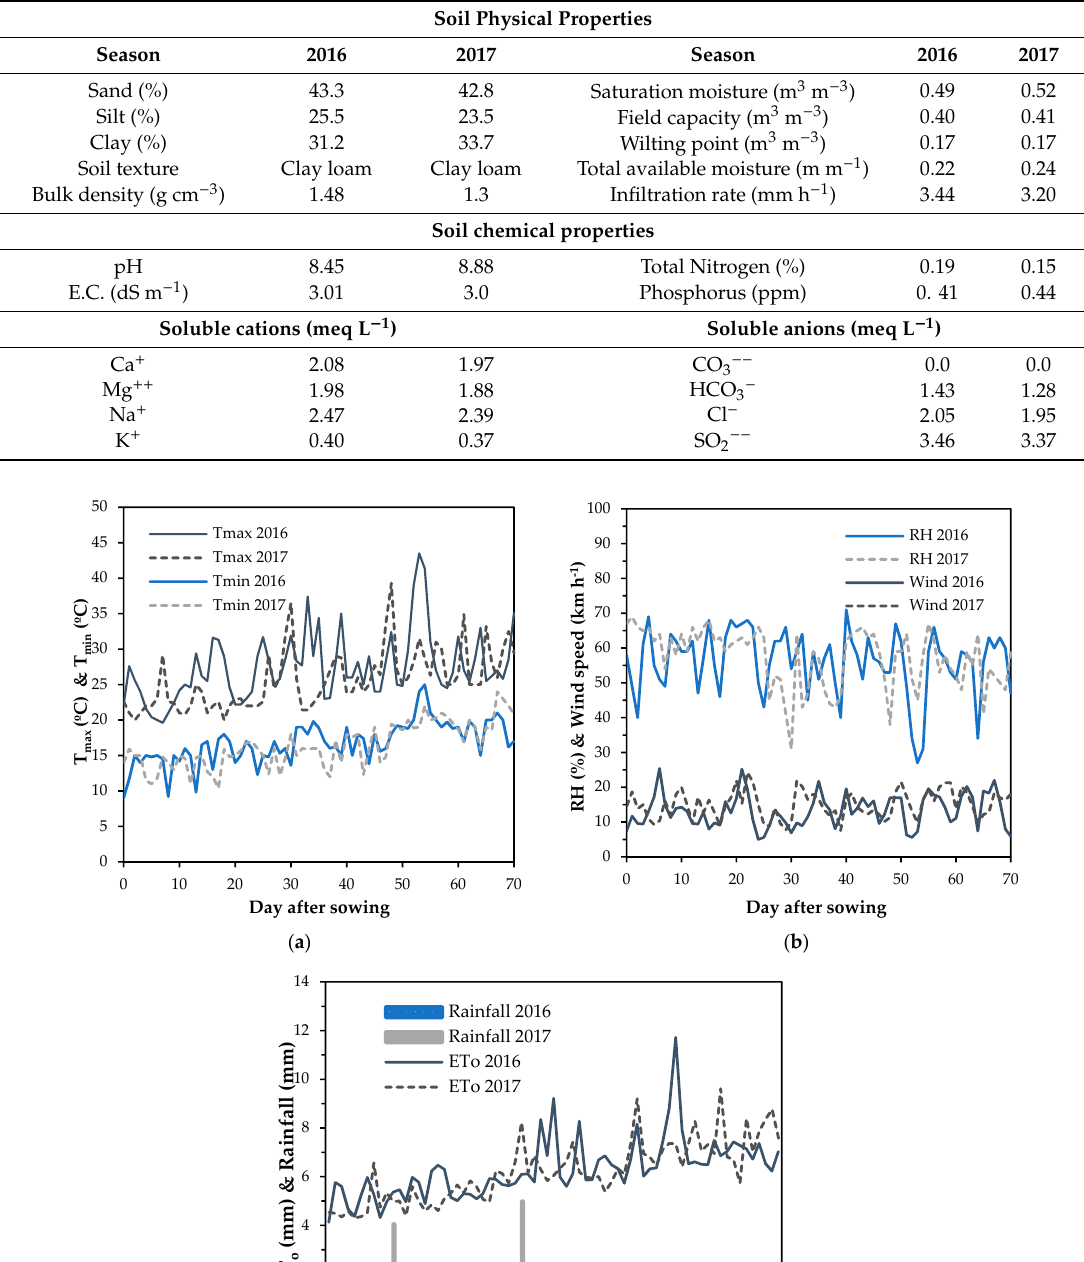
Table 1. Soil physical and chemical properties.